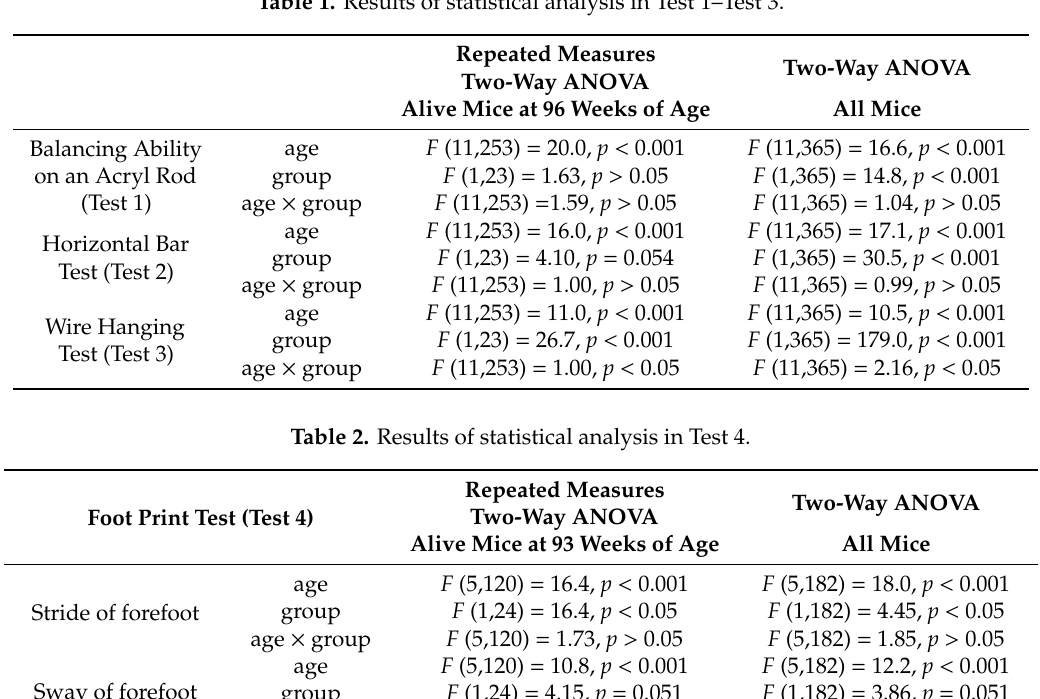
Table 1. Results of statistical analysis in Test 1–Test 3.